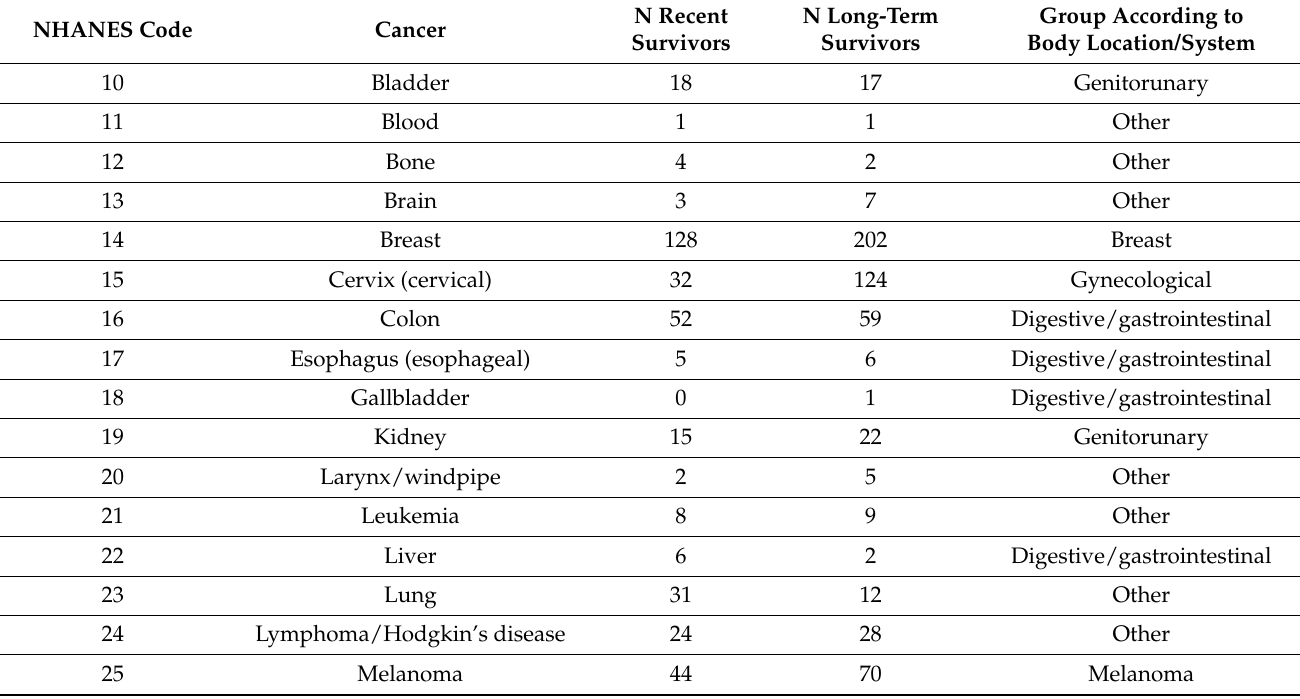
Table A1. Grouping of different cancer types according to body location/system and number of respondents reporting each cancer type among recent and long-term